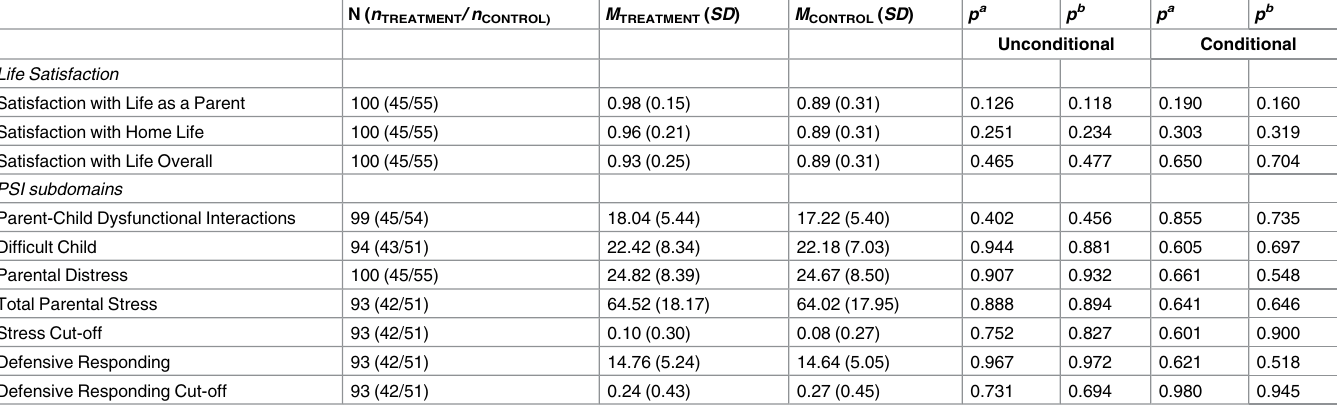
Table 4. Treatment Effects for Global Well-being: Life Satisfaction and Parenting Stress